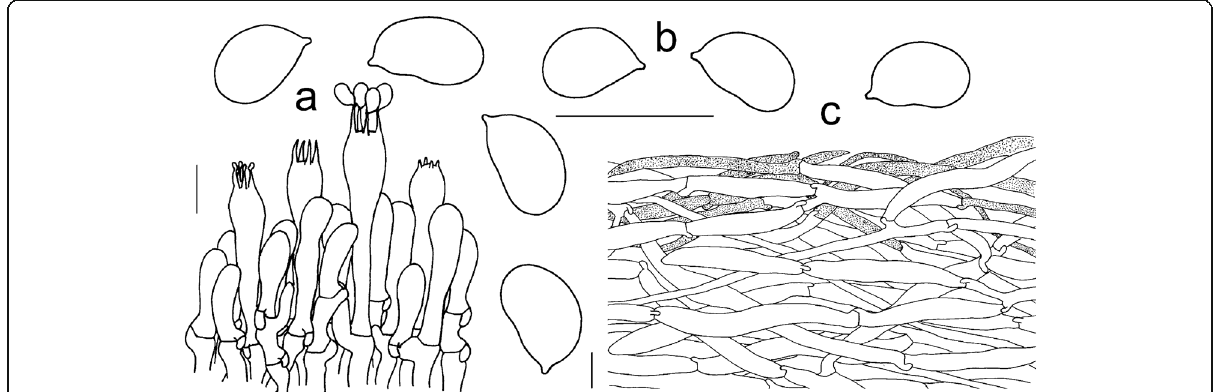
Fig. 7 Microscopic features of Squamanita mira (HKAS100826A, holotype). a Hymenium and subhymenium. b Basidiospores. c Pileipellis section. Bars = 10 μ m. Drawings by Jian-Wei